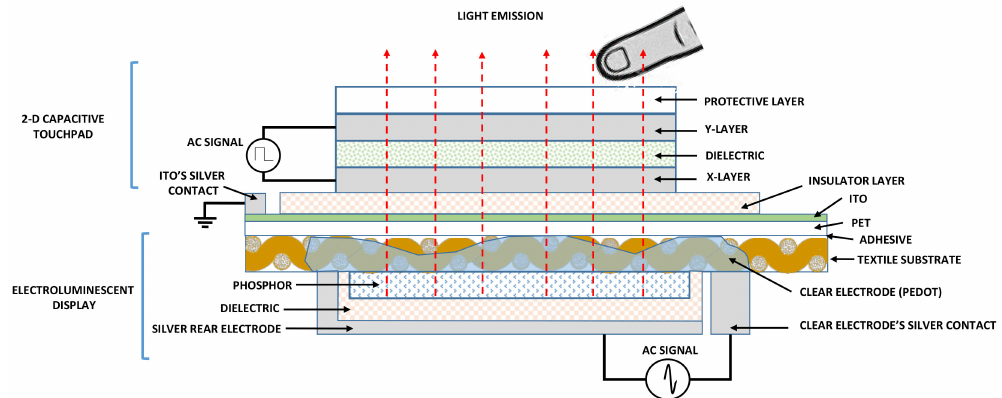
Figure 8. ELD + 2D touchpad architecture with ITO EMI shield. ELD: electroluminescent display; ITO: indium tin oxide; EMI: electromagnetic interferences.